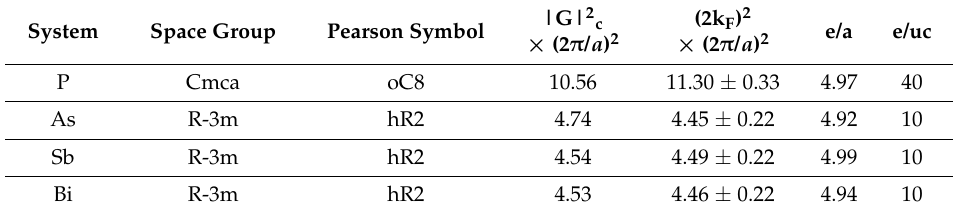
Table 8. Electronic parameters of Group 15 elements of the Periodic